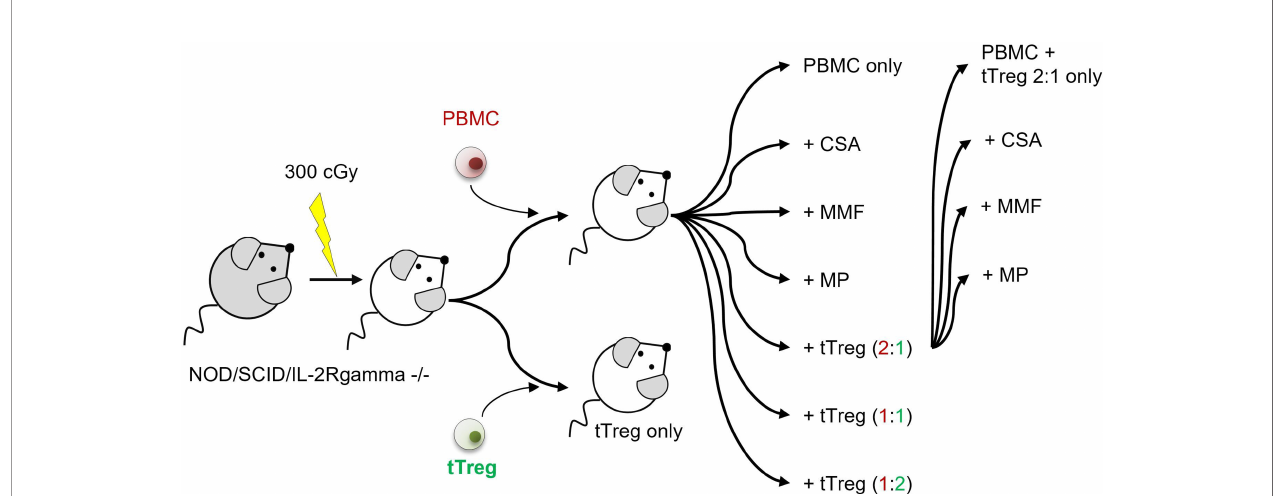
FIGURE 1 | Experimental setup. NOD/SCID/IL-2Rgamma - / - mice were sub-lethally radiated with 300 cGy (day -1). Xenogenic GvHD was induced by intravenous application of 3x10 6 human PBMCs. GvHD control mice did not receive further therapy. tTreg control mice received 3x10 6 ex vivo expanded tTregs. If indicated tTregs were simultaneously administered with PBMCs at a dosage of 1.5x10 6 (PBMC:tTreg ration of 2:1), 3x10 6 (PBMC:tTreg ratio of 1:1) or 6x10 6 (PBMC:tTreg ratio of 1:2). Mice that received either PBMCs alone or in combination with tTregs were further treated daily with the cISD CSA (4 mg/kg/d s.c.), MMF (0.5 mg/d p.o) or MP (20 mg/kg/d i.p.) starting day +1 after cell administration. Animals were monitored daily for body weight and clinical signs of GvHD (behavior, fur alterations, skin in fl ammation, hunched back). Liver, spleen, and lungs were collected on day +35 or when clinical signs required